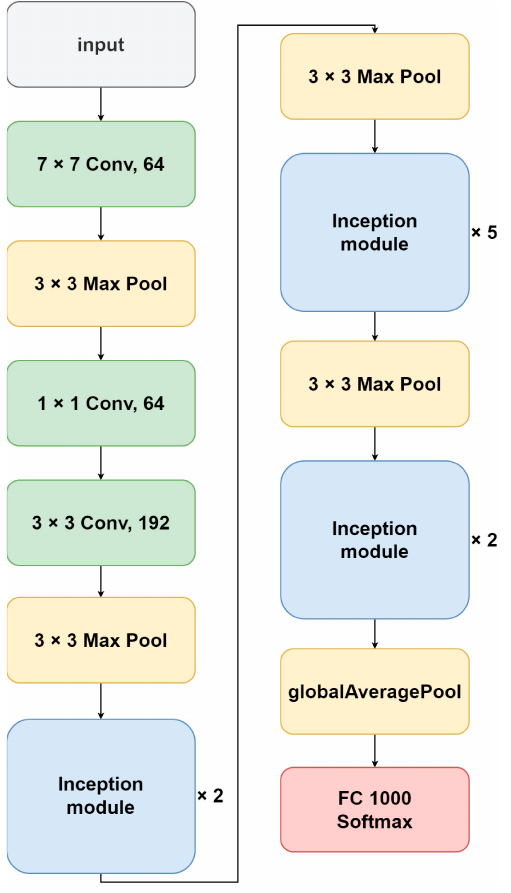
Figure 8. GoogLeNet architecture.